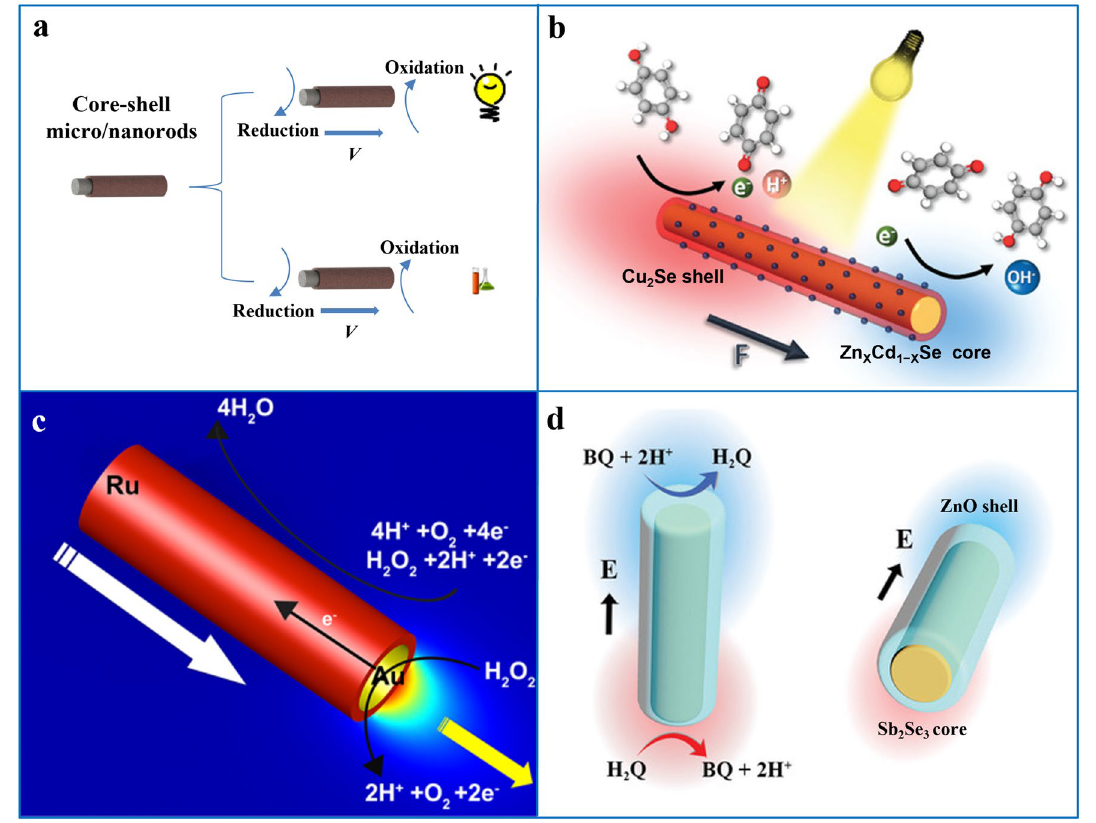
Fig. 6 a Schematic diagram of a core–shell structured nanorods driven under light. b Schematic diagram of photochemically induced electro- phoresis-driven